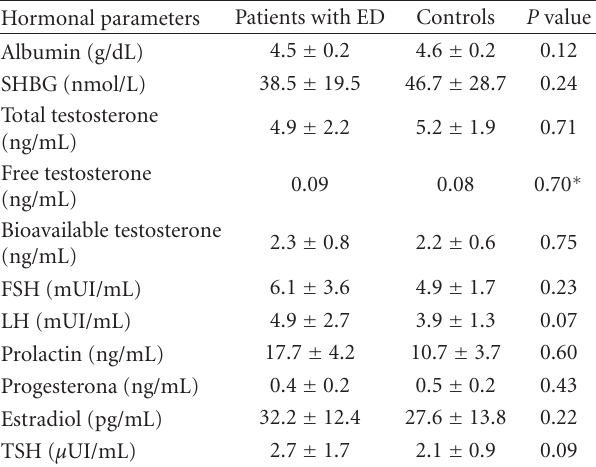
Table 3: Hormonal parameters in patients with ED and controls. No significant di ff erences were found (mean ± SD when normally distributed, median when nonnormally distributed).